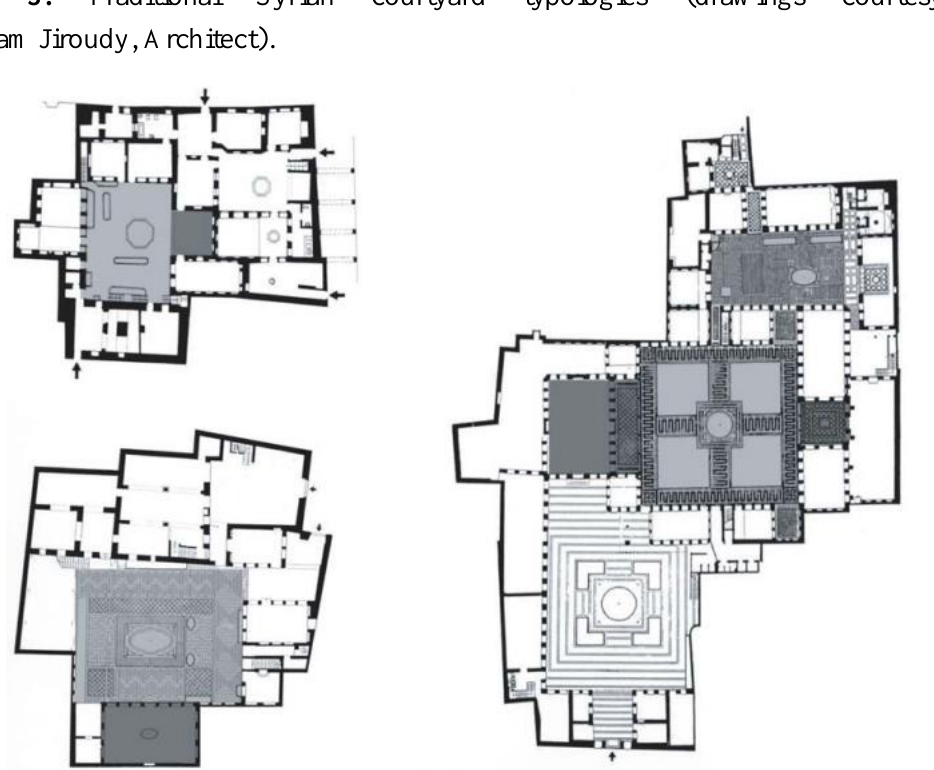
Figure 3. Traditional Syrian courtyard typologies (drawings courtesy of M. Hosam Jiroudy, Architect).